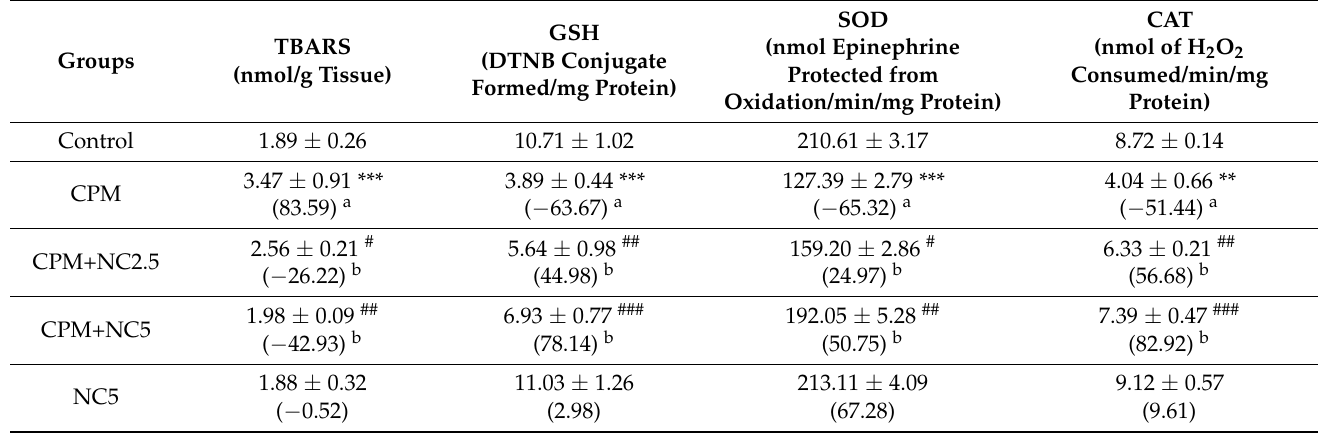
Table 2. Effect of NC treatment on CPM-induced brain stress.